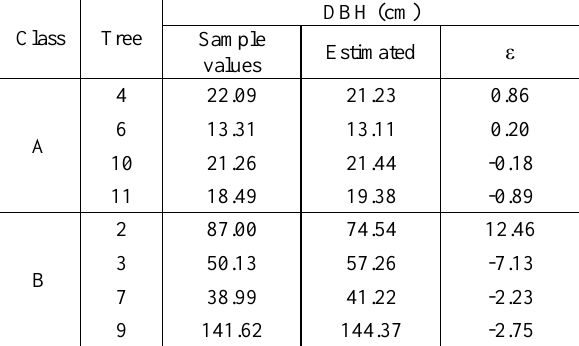
Table 3. Samples of trees used to define the linear mathematical models to estimate DBH for class A and class B.